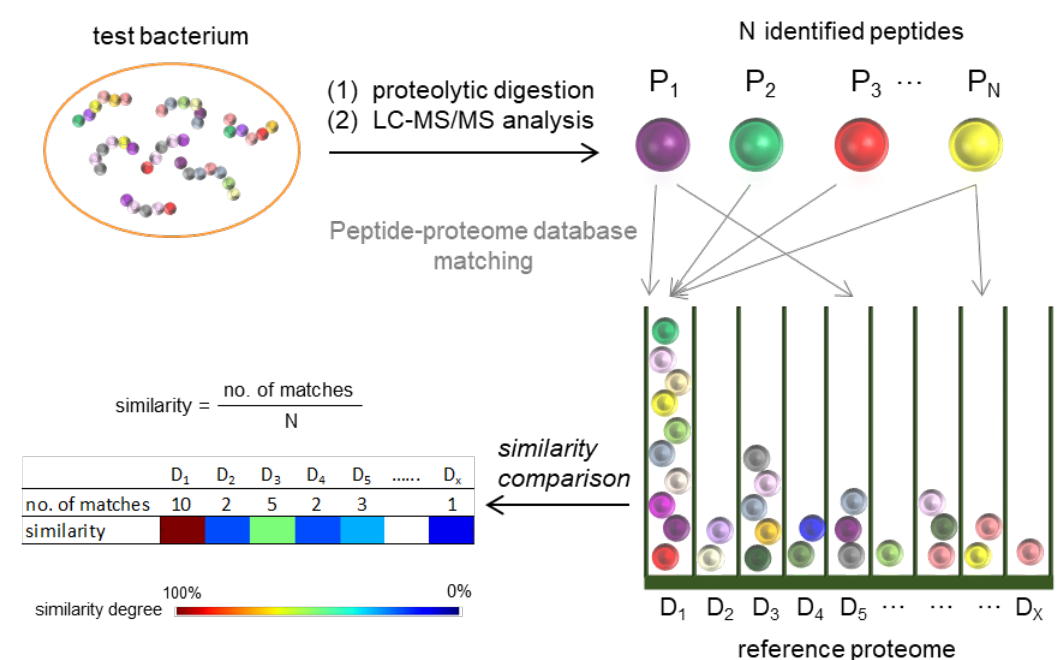
Figure 2. Schematic representation of bacterial classification by a proteomic